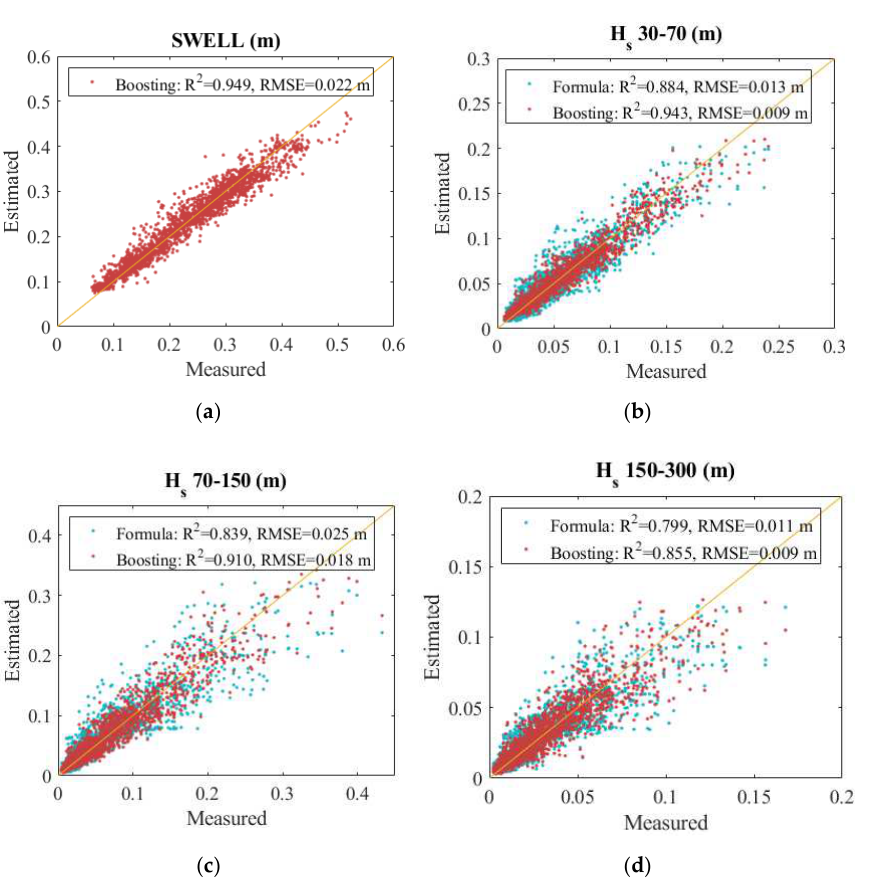
Figure 3. Scatterplot of H s measured and estimated through the classical formula (blue) and the GBM (maroon) with met-ocean parameters for ( a ) H s swell, ( b ) H s 30–70 s, ( c ) H s 70–150 s and ( d ) H s 150–300 s.